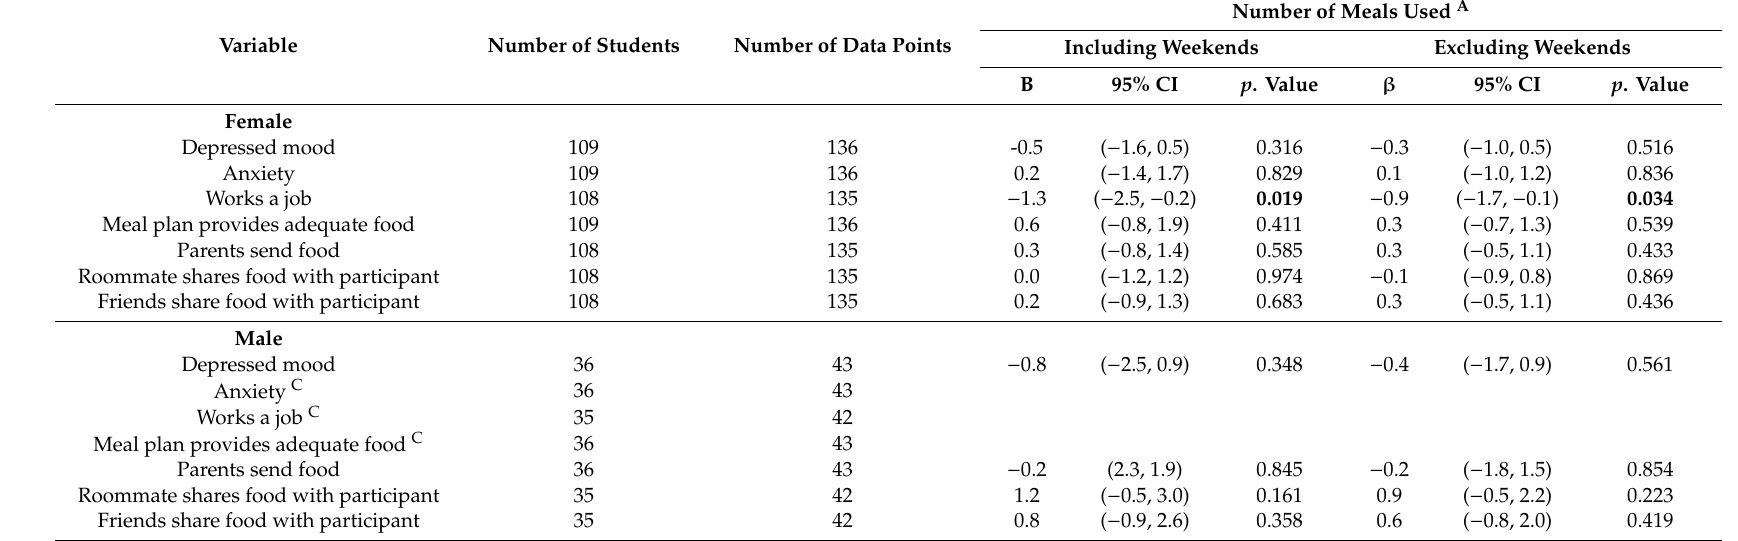
Table 7. Results of the linear generalized estimating equation (GEE) testing what factors are related to the number of meals students used A on the 180 meals / semester B meal plan after stratifying by